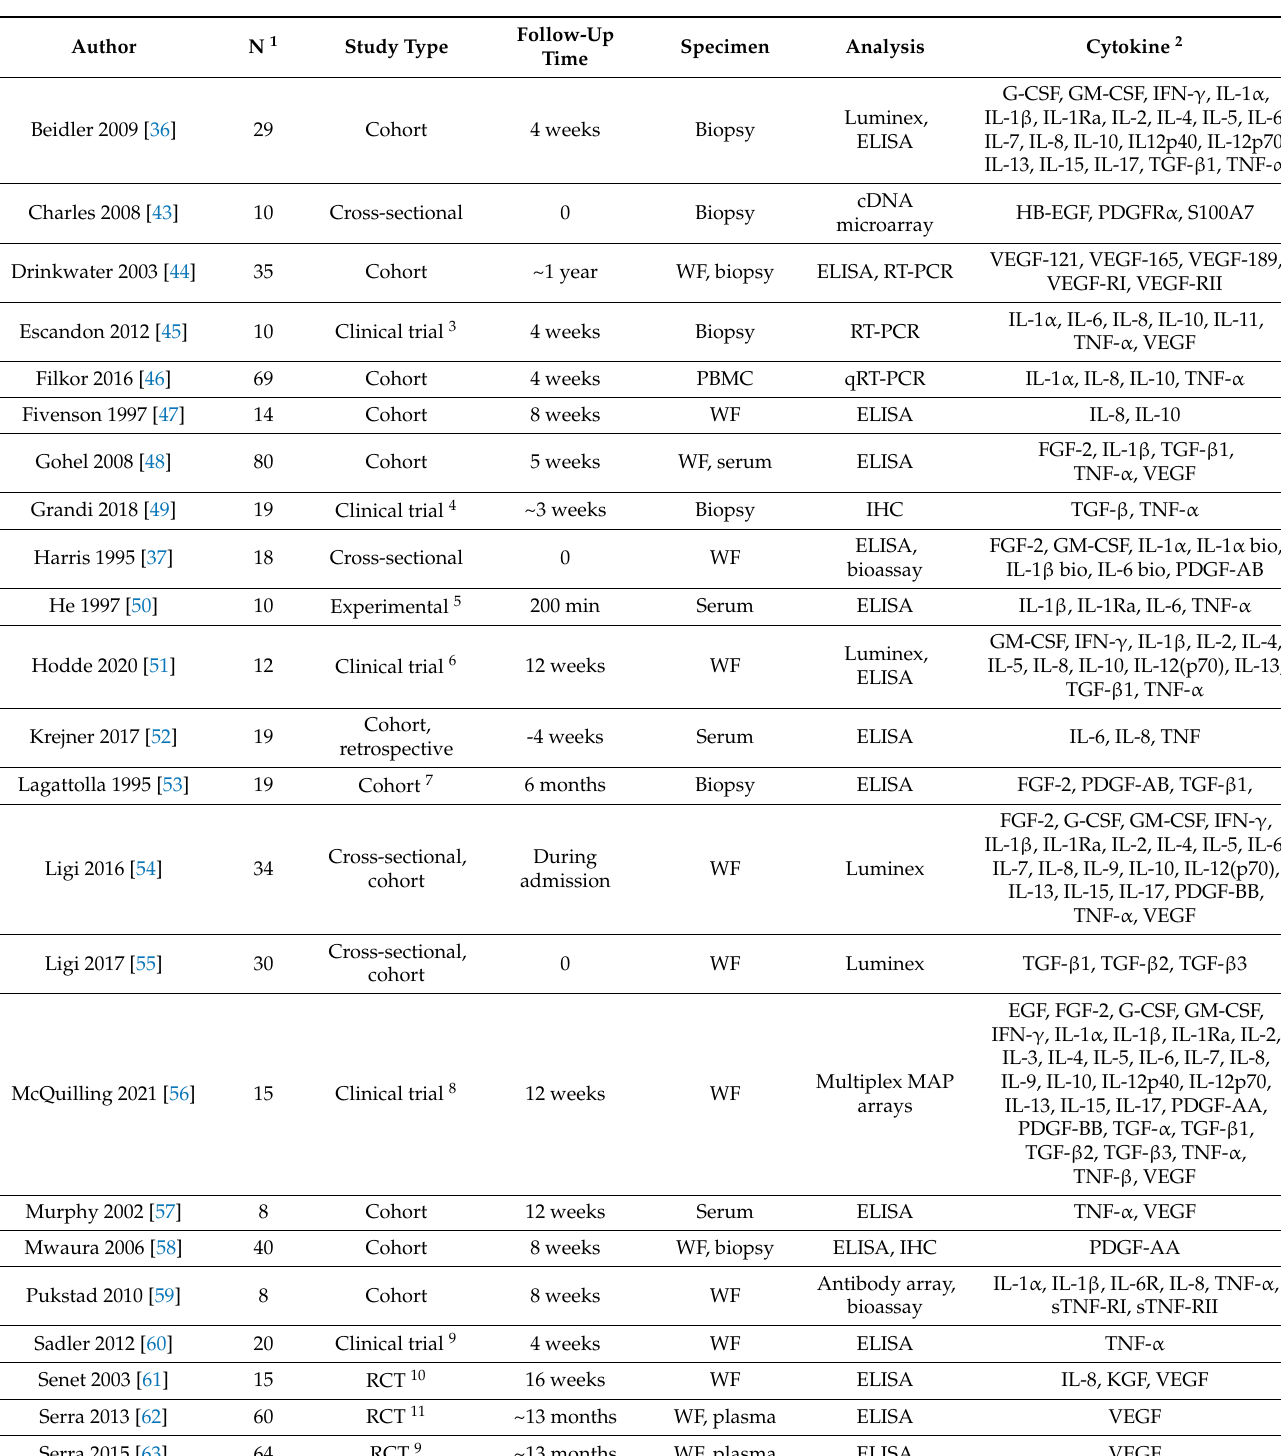
Table 1. Included studies ( n = 28) arranged in alphabetic